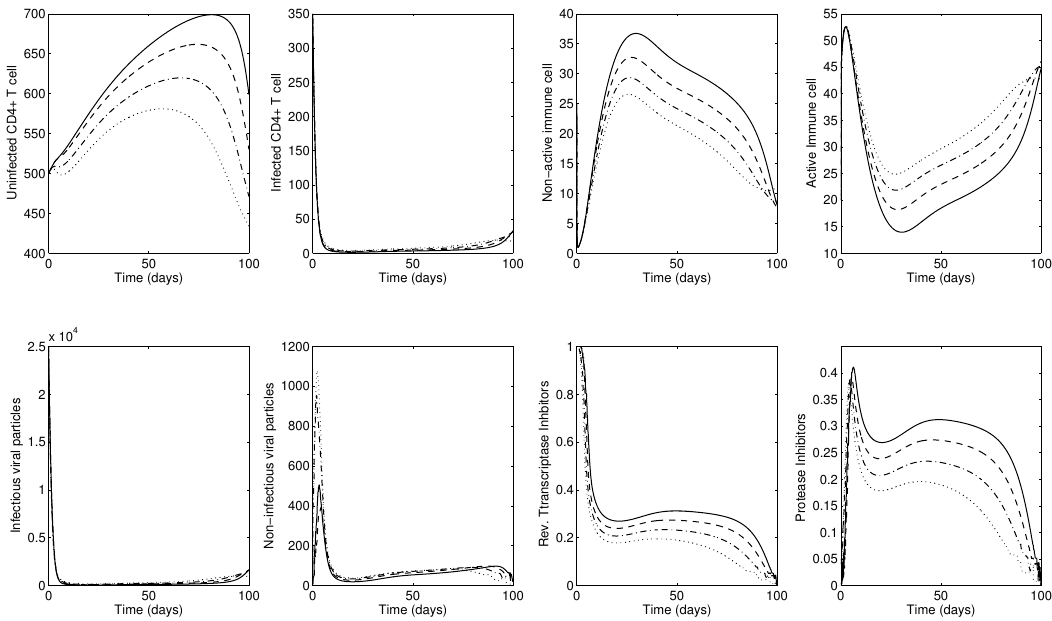
Figure 7. Advanced-stage dynamics of infection with two controls under four different values of weight constants ( β = 0.000025 and γ = 0.004 are used): A = B = 100,000 (solid), A = B = 50,000 (dashed), A = B = 25,000 (dash-dot) and A = B = 12,500 (dotted). The bottom two right panels show optimal controls for reverse transcriptase inhibitor ( u 1 ) and protease inhibitor ( u 2 ) for 100 days. Initially, a maximum level of RTI should be implemented, followed by decreasing the RTI, while the PI should be applied at a medium level during the entire